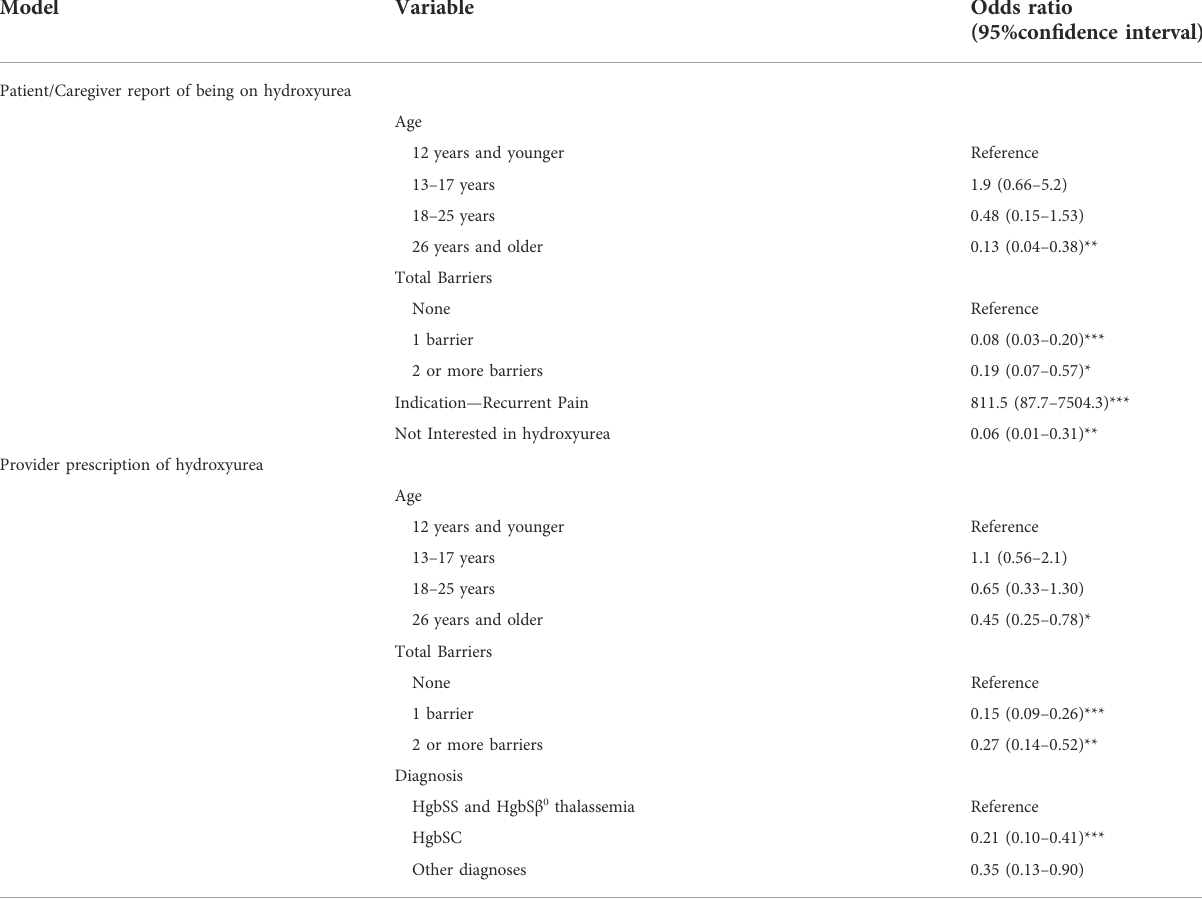
TABLE 5 Signi fi cant multivariable relations between patient/caregiver reports of being on hydroxyurea and provider prescription of hydroxyurea. Model